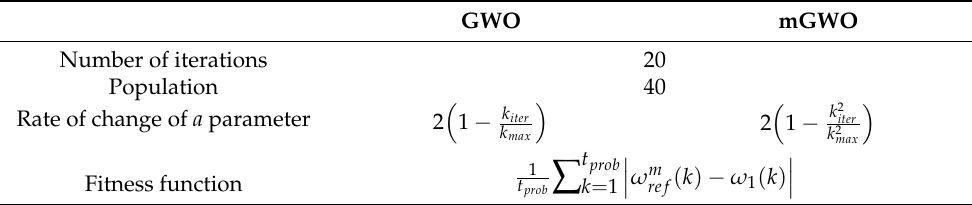
Figure 6. Comparison of fitness function for the GWO and the mGWO. Table 2. Parameters of GWO and mGWO.